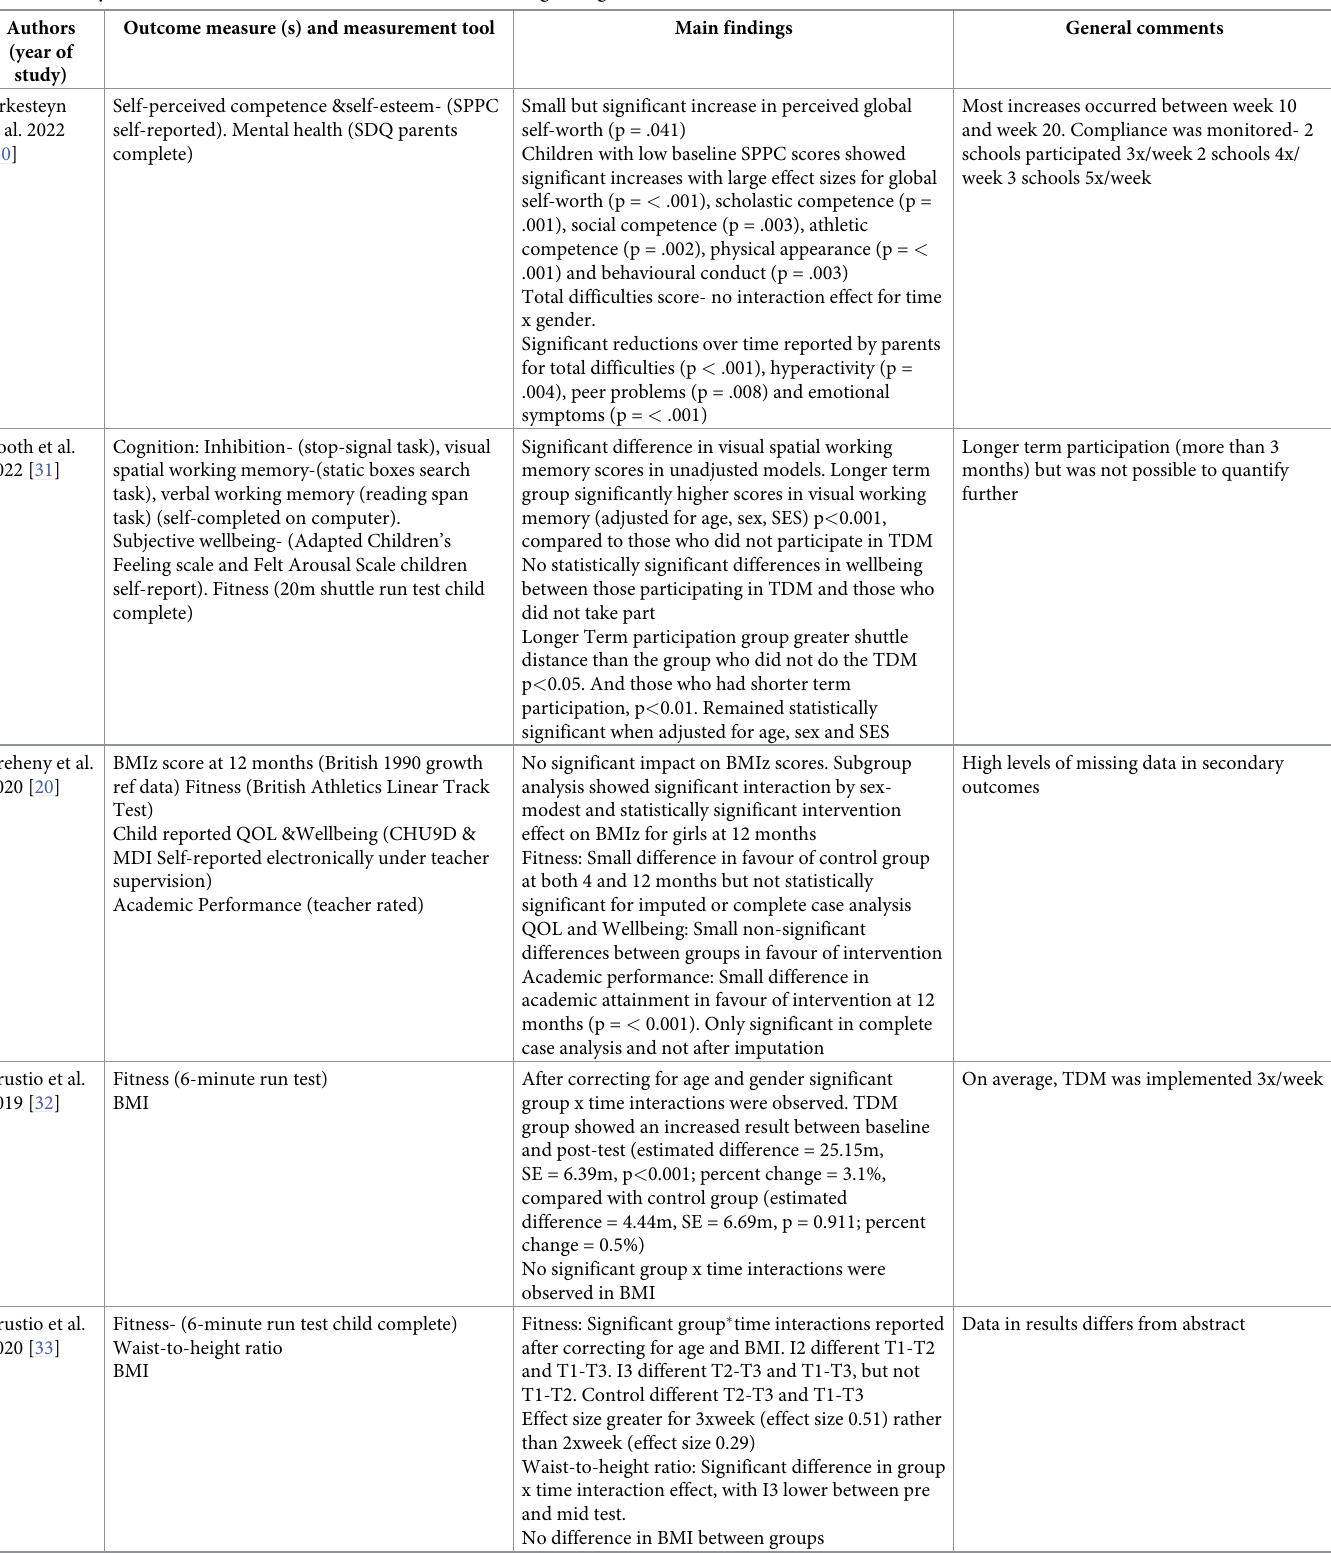
Table 4. Study outcome measures, measurement tools, main findings and general